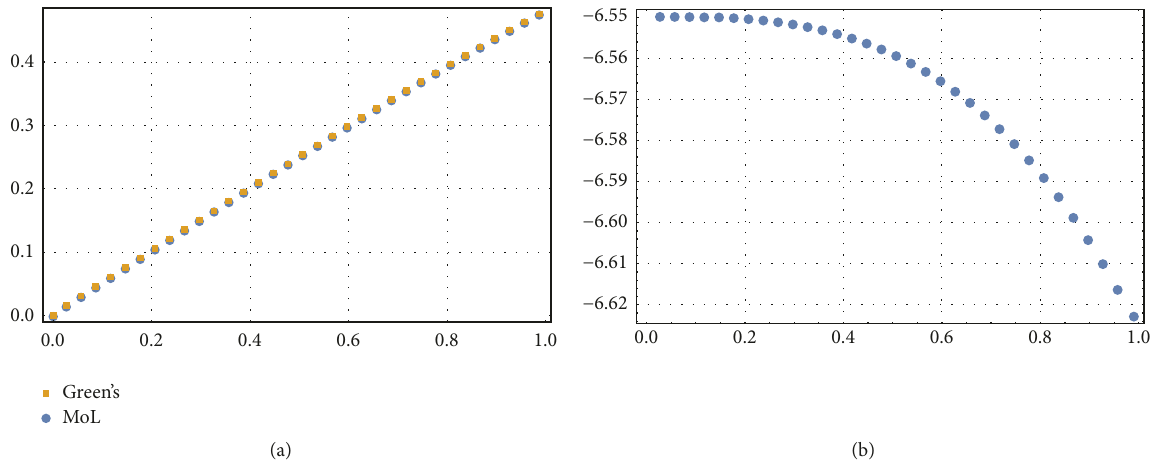
Figure 1: Discrete plot of 𝑤 and 𝑤 MoL (a) and Er (b) against 𝑡 ∈ [0, 1] for 𝑓(𝑡) = 𝛿(𝑡) : quadratic potential. Green’s